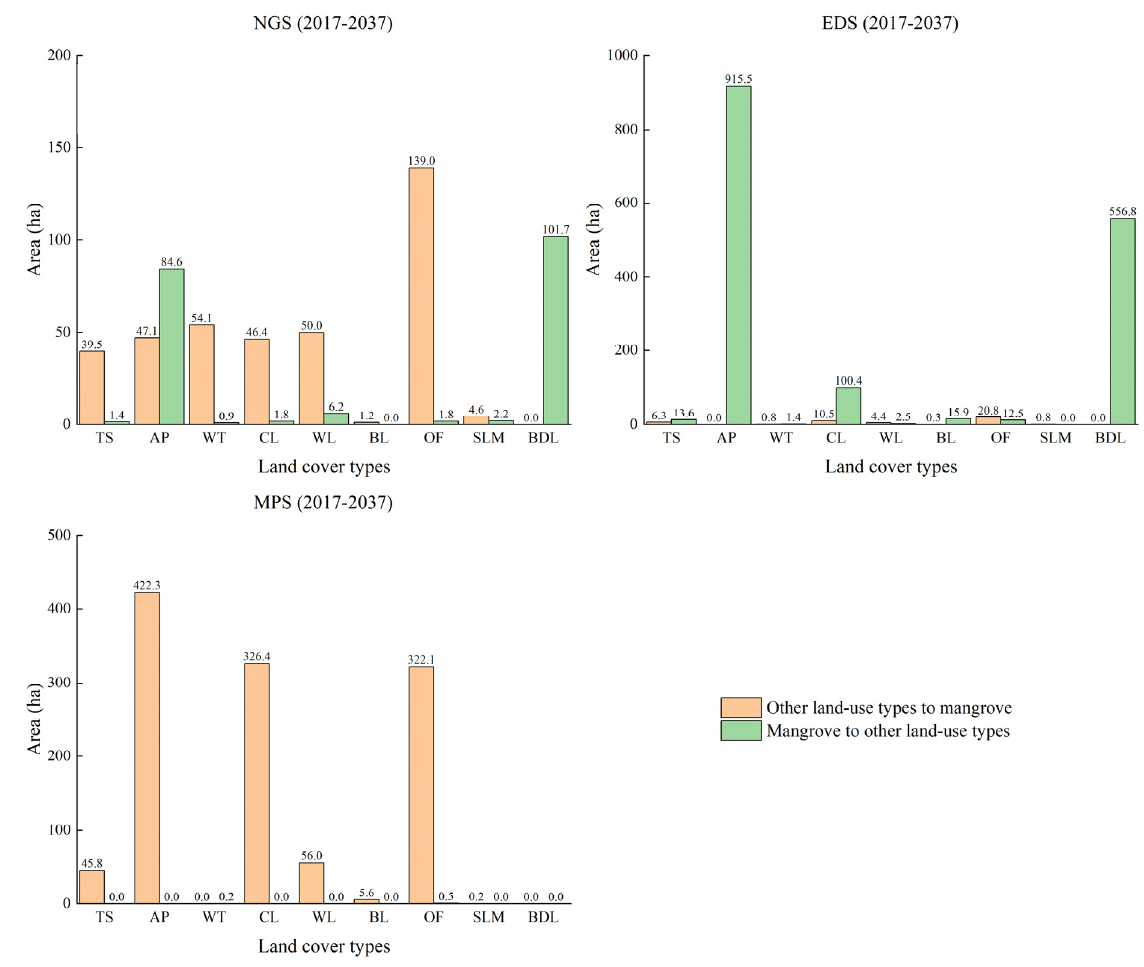
Figure 7. Conversion between mangrove forests and other land cover types from 2017 to 2037 under different scenarios. Figure 8 shows the land cover changes of mangrove forests from 2017 to 2037 under NGS. The mangrove area of all protected areas generally increased. Only the coastal of Puqian (Zones B1 and B2), the central of Guanan (Zones C1 and C2) and the western of Dongzhaigang (Zone E1) decreased significantly. Most of the mangrove growth areas were around existing mangrove forests (Zones A1, D1, D2, F1, F2, G1, H1 and I1) or along the riverbank (Zone I2).